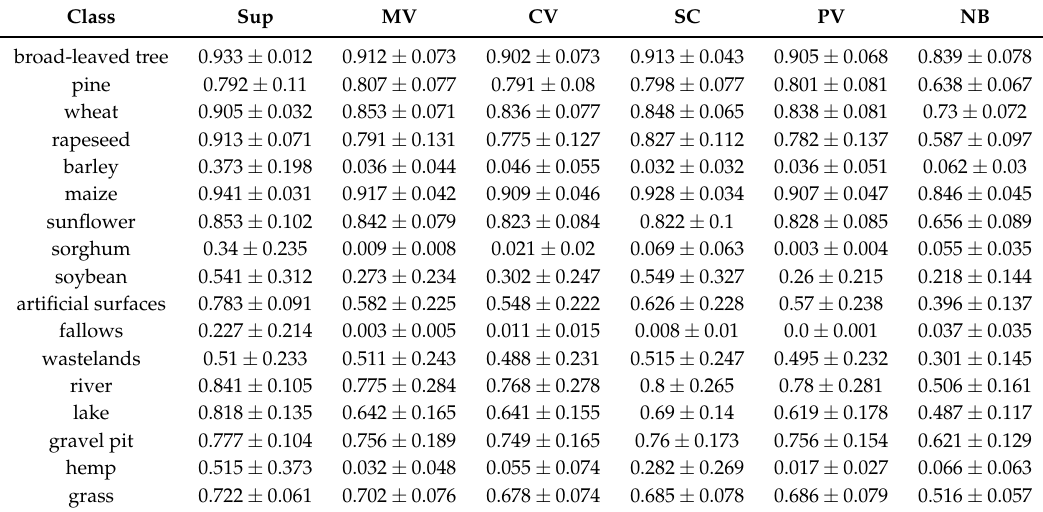
Table 3. Fscore obtained for all periods confounded by each method. The columns are: Sup for the standard Supervised case, MV for Majority Voting, CV for Confidence Voting, SC for Single Classifier, PV for Probability Voting and NB for the Naive Baseline